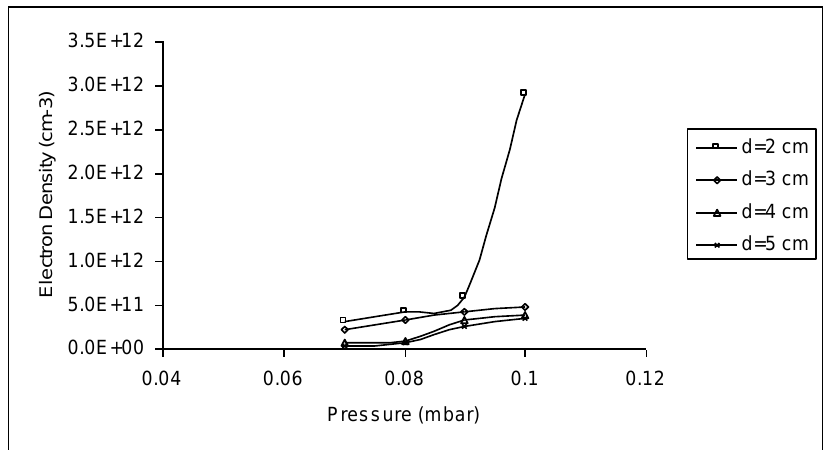
Fig.5: Electron density with plasma pressure at different electrode